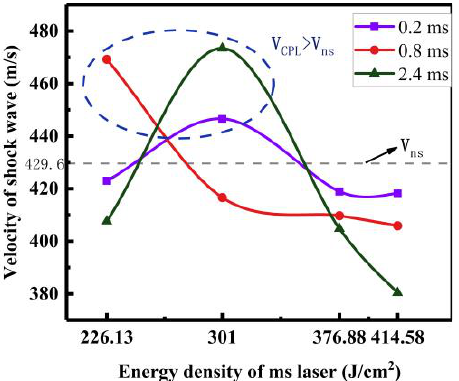
Figure 4. The relation between shock wave velocity and ms laser energy densities.